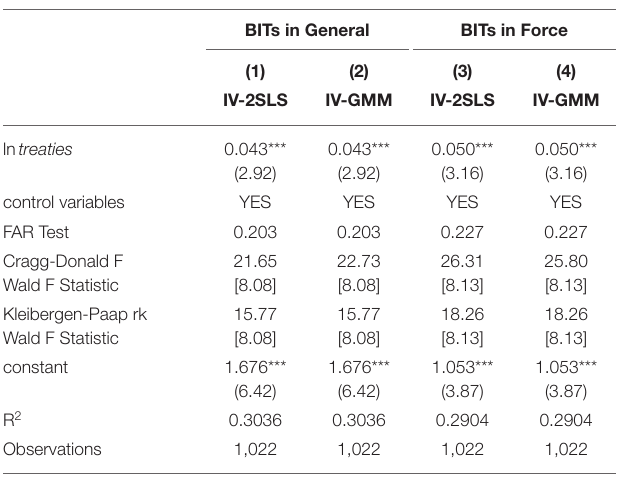
TABLE 4 | Robustness test I.